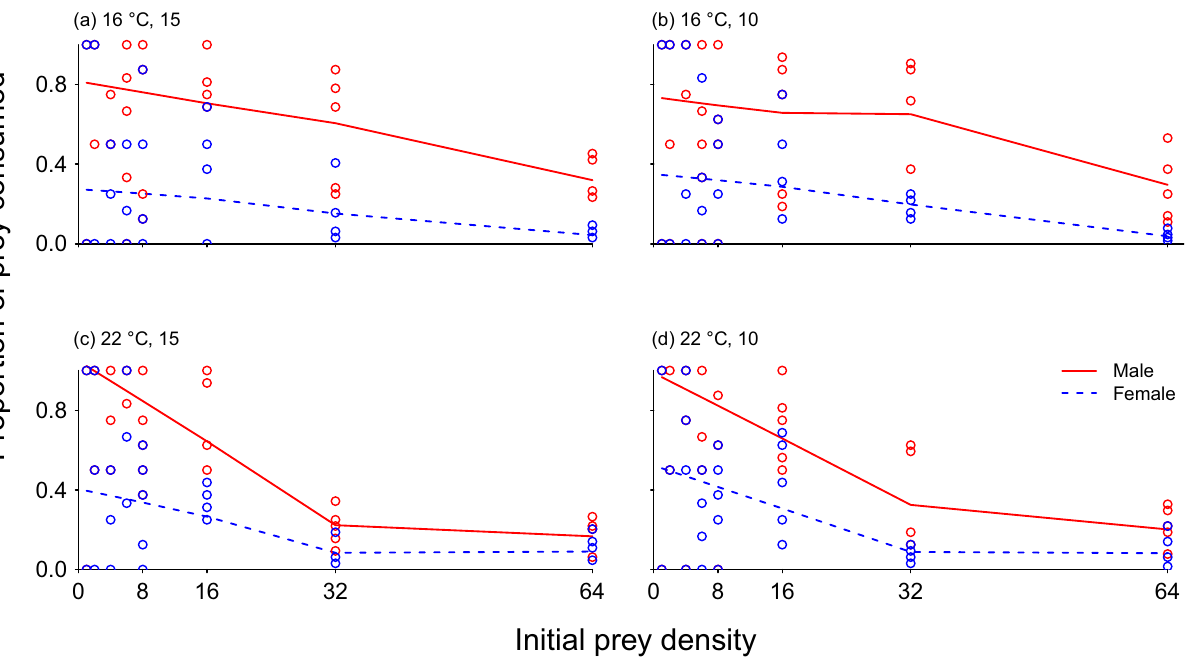
Figure 2. Locally weighted scatterplot smoothing lines fit to the proportion of prey consumed at each Mytilus edulis prey density for male and female Hemigrapsus takanoi with underlaying data points for ( a ) ambient salinity and ambient temperature, ( b ) desalination and ambient temperature, ( c ) ambient salinity and warming, ( d ) desalination and warming.